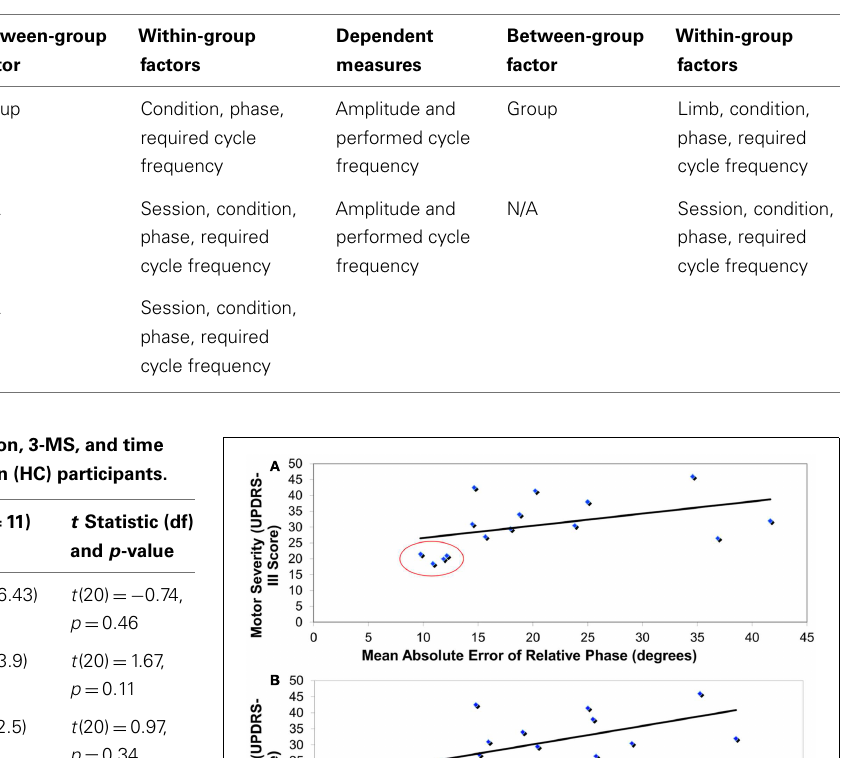
Table 3 | Description of statistical comparisons.